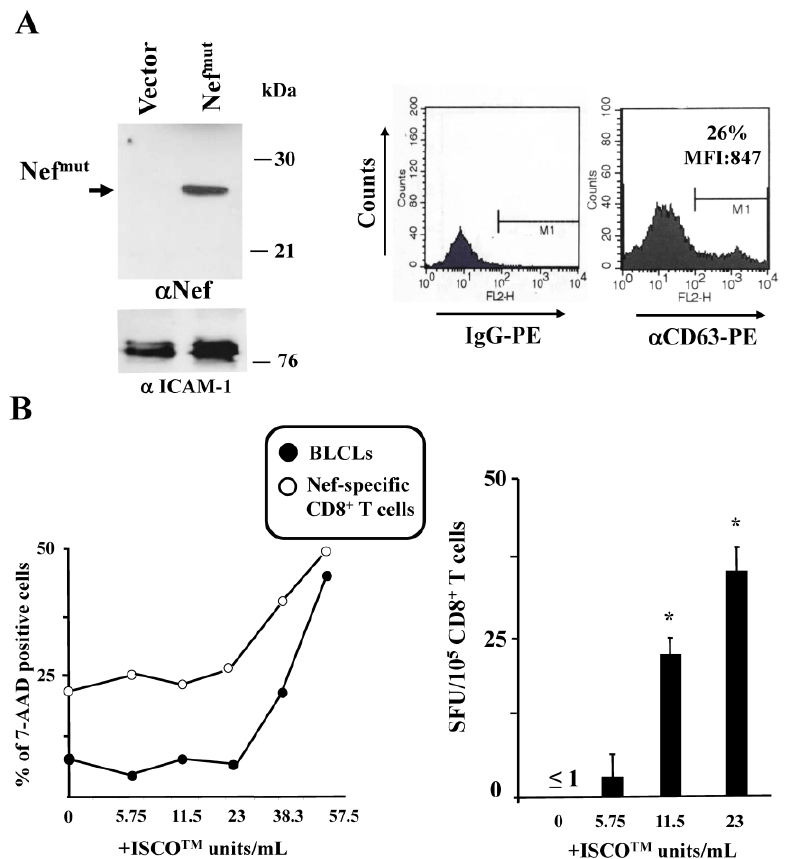
Figure 3. ISCOMATRIX TM adjuvant increases the cross-presentation of antigens delivered by engineered exosomes in B-lymphoblastoid cell lines (LCLs). ( A ) molecular characterization of exosome preparations uploading Nef mut . On the left is the Western blot analysis of 200 µ U of exosomes uploading Nef mut . As a control, equivalent amounts of exosomes from cells transfected with the empty vector were loaded. Arrow signs indicate the relevant protein product. Exosome preparations were also probed for the presence of Intercellular adhesion molecule (ICAM)-1, i.e., an exosome marker. Molecular markers are given in kilodaltons (kDa). On the right, fluorescence-activated cell sorting (FACS) analysis for the presence of CD63 in exosome membrane uploading Nef mu is shown. M1 marks the range of fluorescence positivity as determined by the analysis of equivalent amounts of exosomes after incubation with isotype-specific IgGs ( left histogram). Both percentages and MFI of fluorescent beads are indicated. Results shown in both panels are representative of three assays carried out on two exosome preparations; ( B ) on the left is cell viability of both B-LCLs and Nef-specific CD8 + T cells treated for 24 h with the indicated concentrations of ISCOMATRIX TM adjuvant as evaluated by FACS analysis after 7-AAD labeling. Shown are mean values from two independent experiments with duplicates. On the right, data from cross-presentation analysis of Nef mut delivered by exosomes in B-LCLs are presented. A total of 10 5 cells were challenged with 100 µ U of exosomes and then cultivated for 5 h in the presence of the indicated doses of ISCOMATRIX TM adjuvant. Thereafter, the cells were put in co-culture overnight with a Nef-specific, HLA-B7 restricted CD8 + T cell line in IFN- γ Elispot microwells. Shown are the mean + SD number of SFU/10 5 cells calculated from five independent experiments. * p < 0.05.